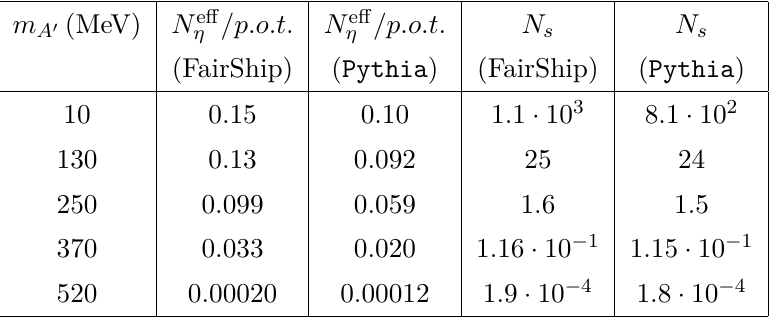
Table 4. Comparison between η samples generated using FairShip (with an energy cut of E cut > 500 MeV in secondary vertices) and Pythia . N eff which give raise to LDM particles within the geometrical acceptance. N